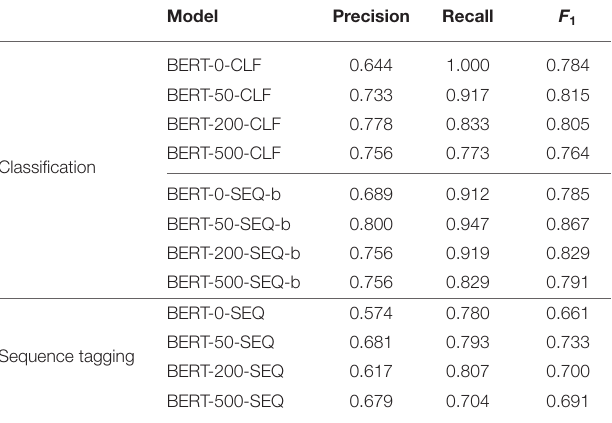
TABLE 6 | Performance on both tasks on the samples of the SIG dataset. Model Precision Recall F